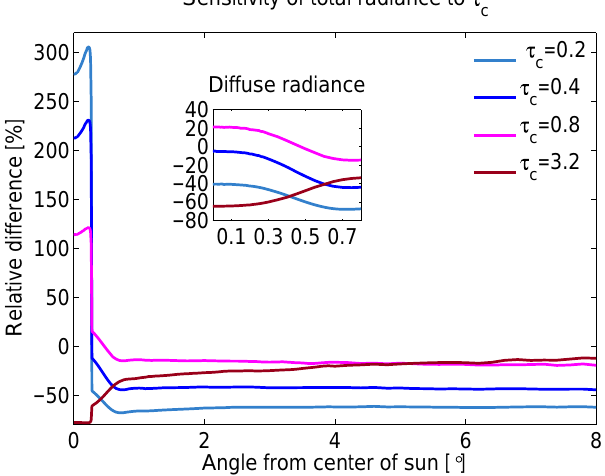
Figure 7. Sensitivity of the disk and circumsolar radiances to cloud optical thickness when the cloud is described using the large A dis- tribution of SR ice crystals. Relative differences between radiances simulated with alternative cloud optical thicknesses ( τ c of 0.2, 0,4, 0,8, and 3.2) and τ c = 1 . 6 are displayed. The insert shows the rel- ative differences in diffuse radiance at angles of 0–0.8 ◦ . In these simulations τ a = 0 .